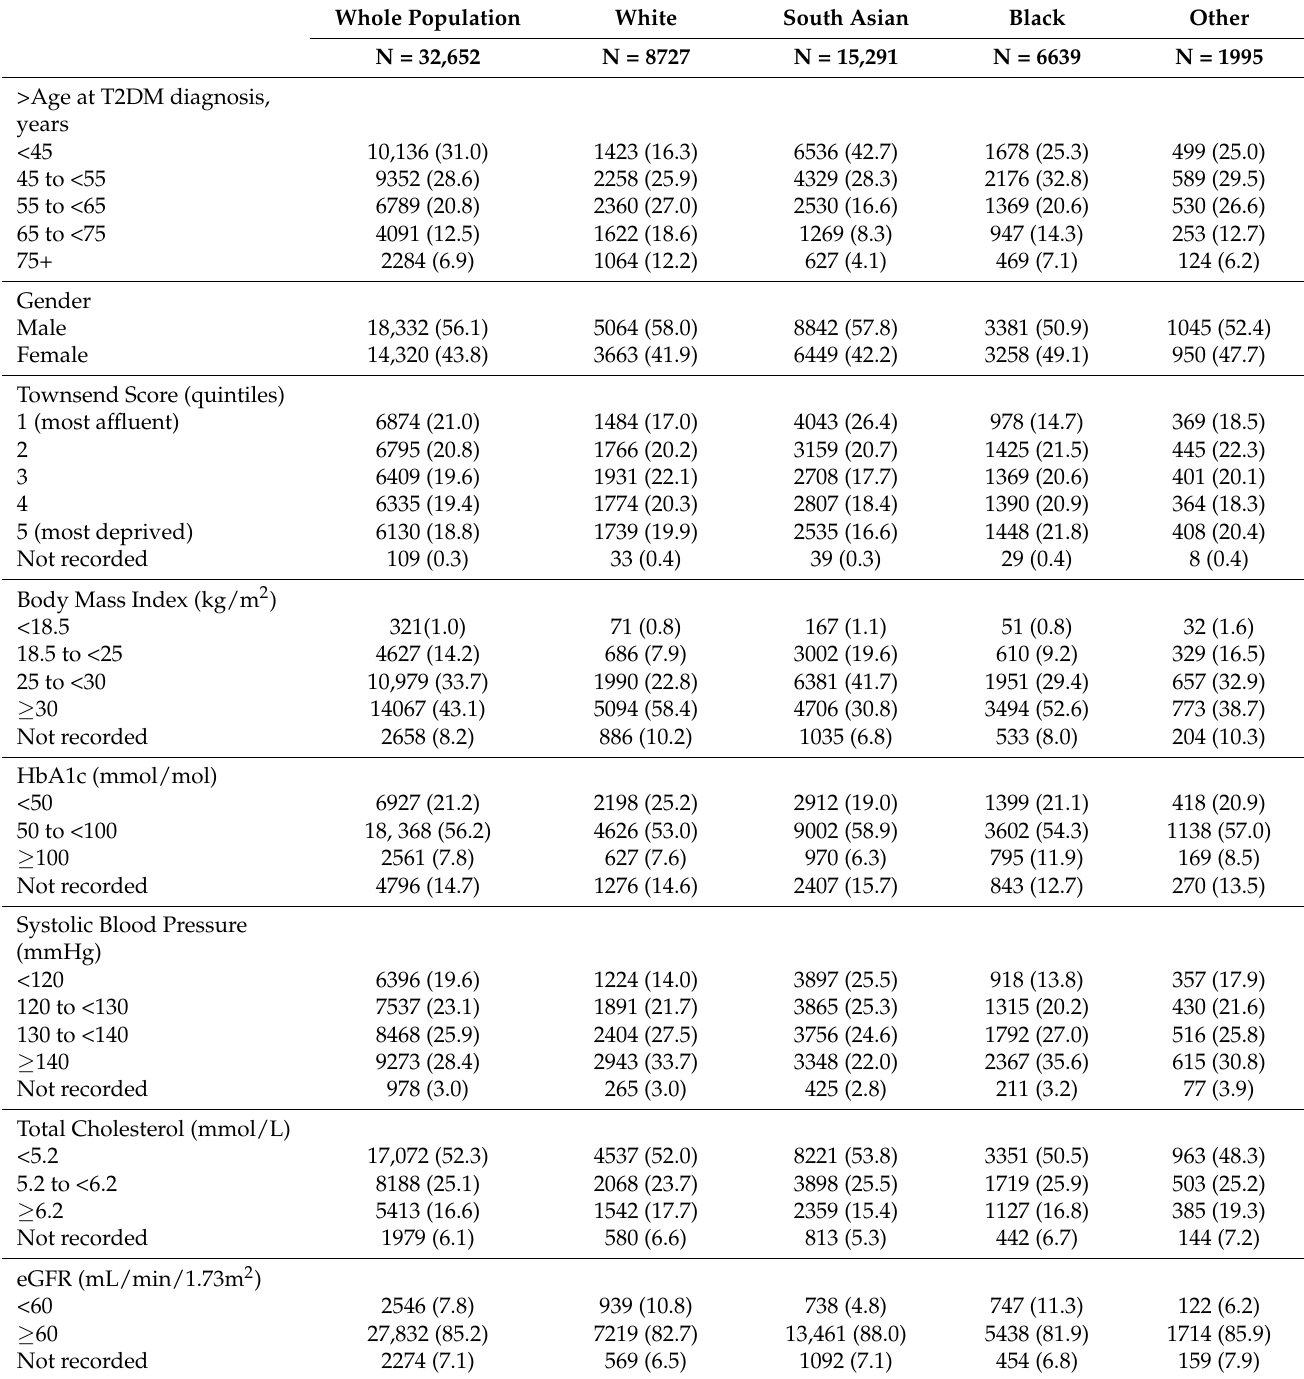
Table 1. Baseline characteristics of the study population—People with newly diagnosed type 2 diabetes. Whole Population White South Asian Black Other N = 32,652 N = 8727 N = 15,291 N =